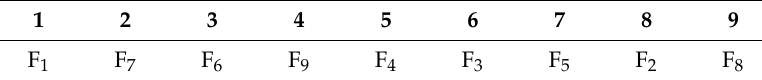
Figure 7. System quality function deployment (QFD). Table 12. Priority ranking of technical features.